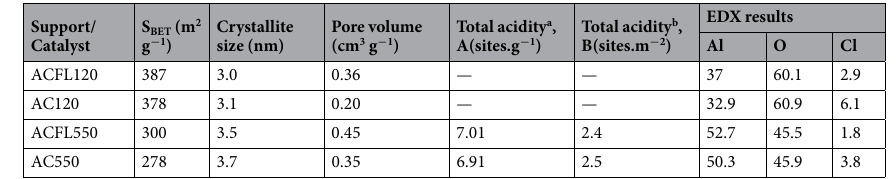
Table 1. Surface area (S BET (m 2 g − 1 )) and pore volume (cm 3 g − 1 ) for different acidic supports. a Total acidity = A × 10 20 . b Acid density = B × 10 18